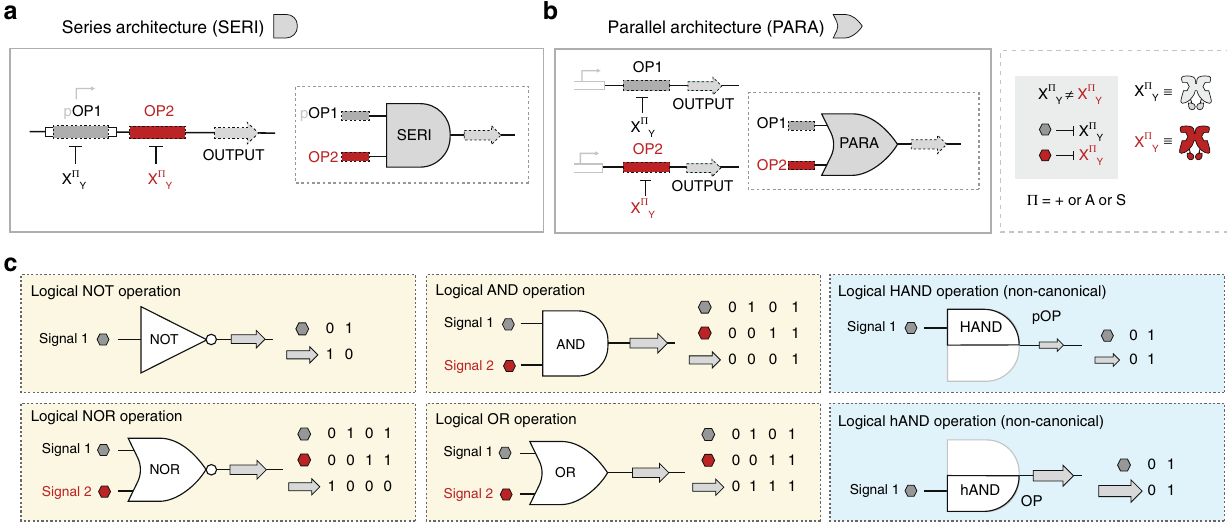
Fig. 4 Genetic architectures and biological truth tables for logical operations. a In the series architecture (SERI), two operators are employed, each acted on by a transcription factor with a different ADR unit. The fi rst operator (pOP1) lies within the promoter element, fl anked by the − 35 and − 10 hexamers in the core position, while the second operator (OP2), lies downstream in the proximal position. b In the parallel architecture (PARA), a single operator controls a single output, but multiple outputs exist on a given plasmid. c Canonical logical operations (yellow boxes) along with corresponding truth tables. Gray and red hexagons represent distinct inputs selected from the fi ve ligands in this work. Non-canonical logical operations (blue boxes) stemming from the series architecture. When the core operator is controlled, the resulting operation is denoted a HAND, while controlling the proximal operator leads to a